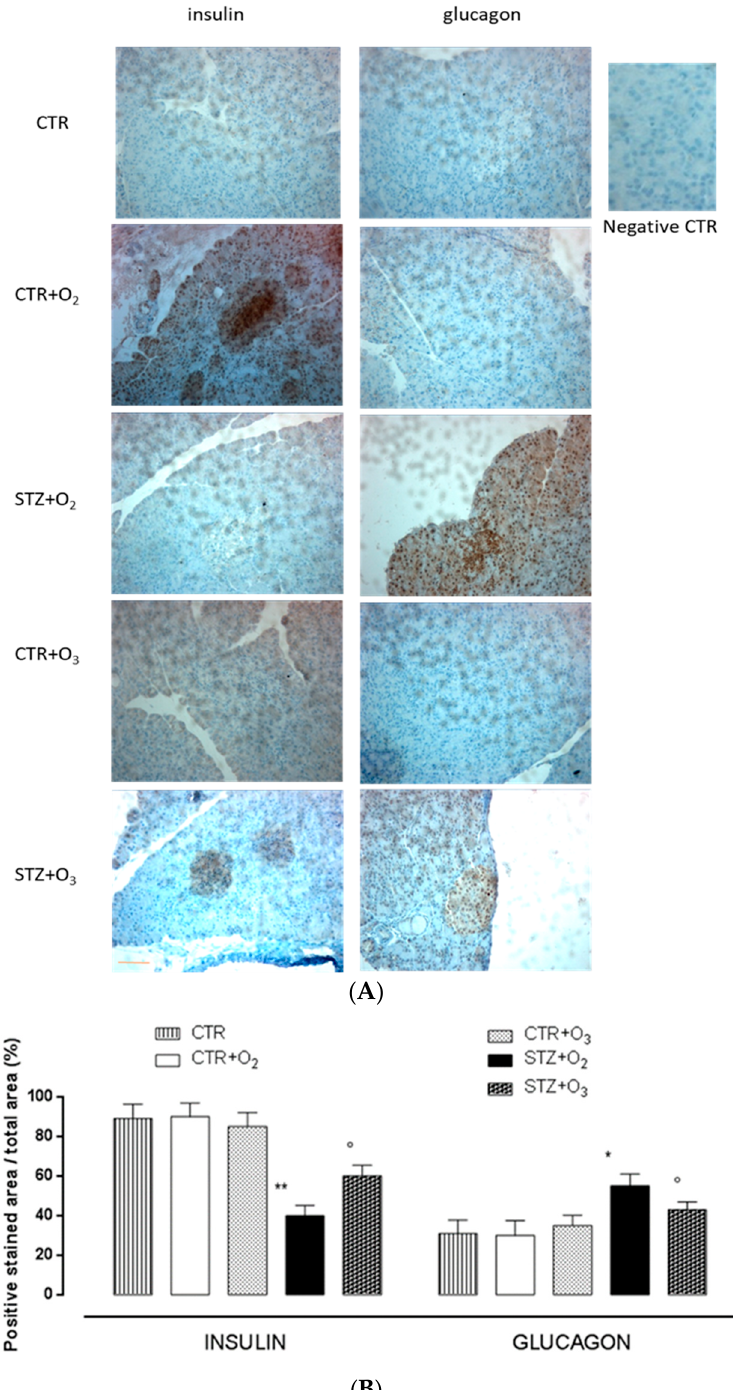
Figure 7. Insulin and glucagon immunostaining. ( A ) The picture shows insulin and glucagon immunostaining in pancreatic tissues. Scale-bar: 50 µm. ( B ) Results are expressed as positive stained area ± s.e.m. CTR = saline-treated rats; CTR + O 2 = oxygen-treated rats; CTR + O 3 = ozone-treated rats; STZ + O 2 = oxygen-treated STZ rats; STZ + O 3 = ozone-treated STZ rats. * p < 0.05 vs. CTR + O 2 ; ** p < 0.01 vs. CTR + O 2 ; ° p < 0.01 vs. STZ + O 2 . The insert represents the negative CTR: Negative control (without primary antibody) for staining in order to confirm antibody specificity.